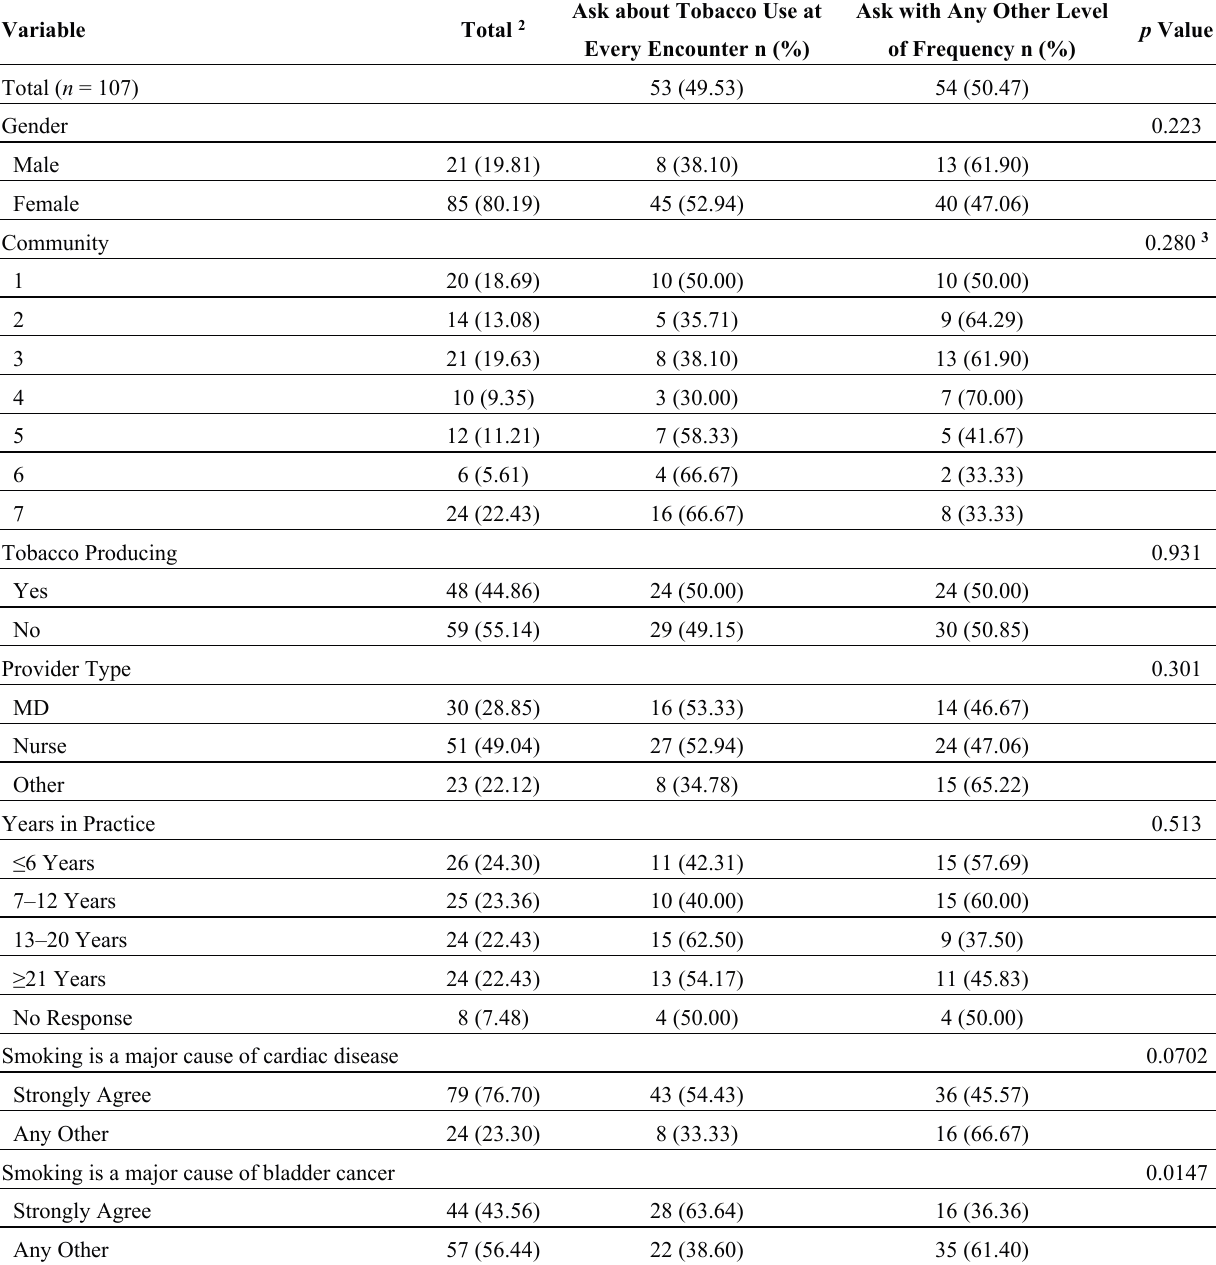
Table 4. Bivariate analysis of factors associated with asking about tobacco use 1